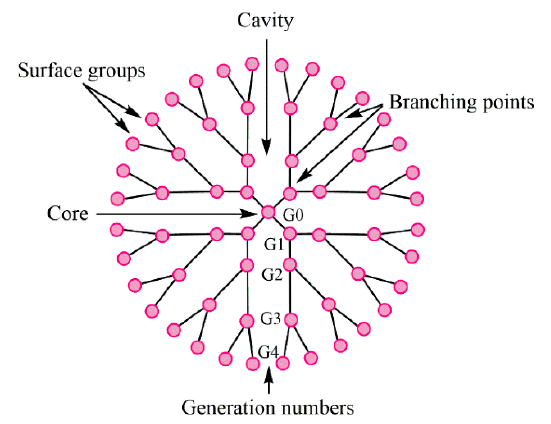
Figure 18. The structure of typical dendrimer. Reproduced from [68], with permission from MDPI,